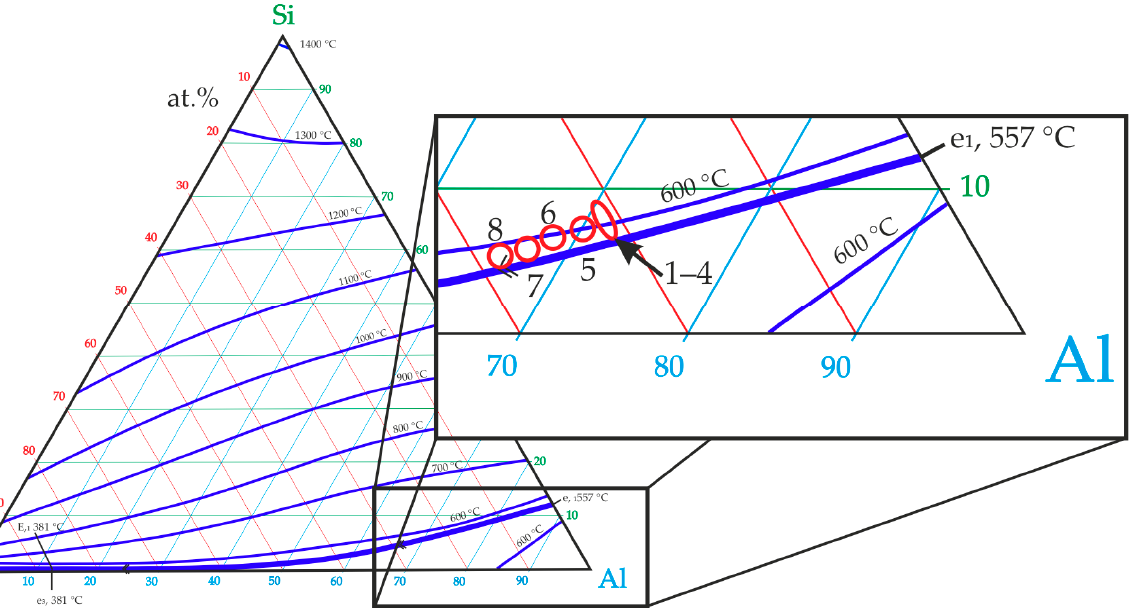
Figure 3. Liquidus plot of the aluminum–zinc–silicon phase diagram according to [21] with the selected alloy compositions 1–8 highlighted by red symbols.